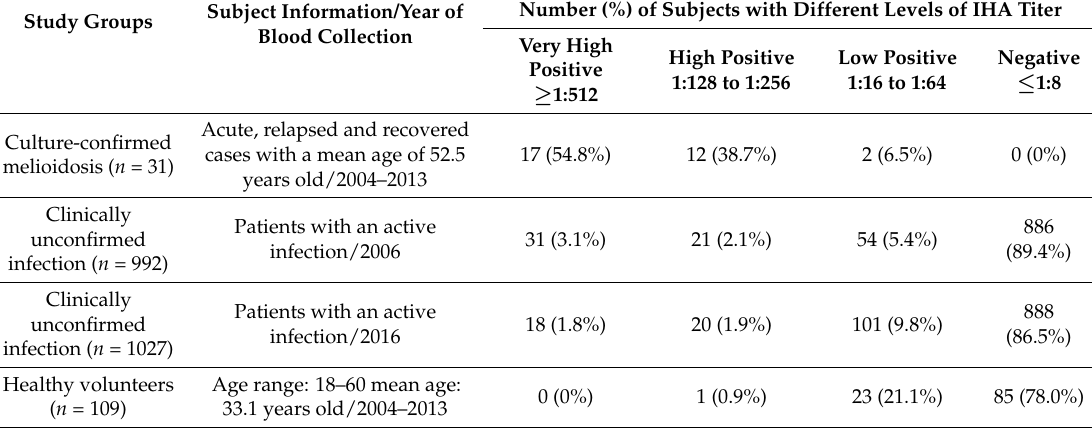
Table 1. IHA results on serum samples collected from culture-confirmed melioidosis patients, suspected melioidosis cases presenting to local hospitals and healthy volunteers from 2004 to 2016